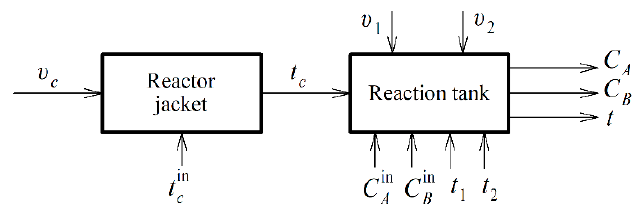
Figure 2. Structural diagram of the control object.